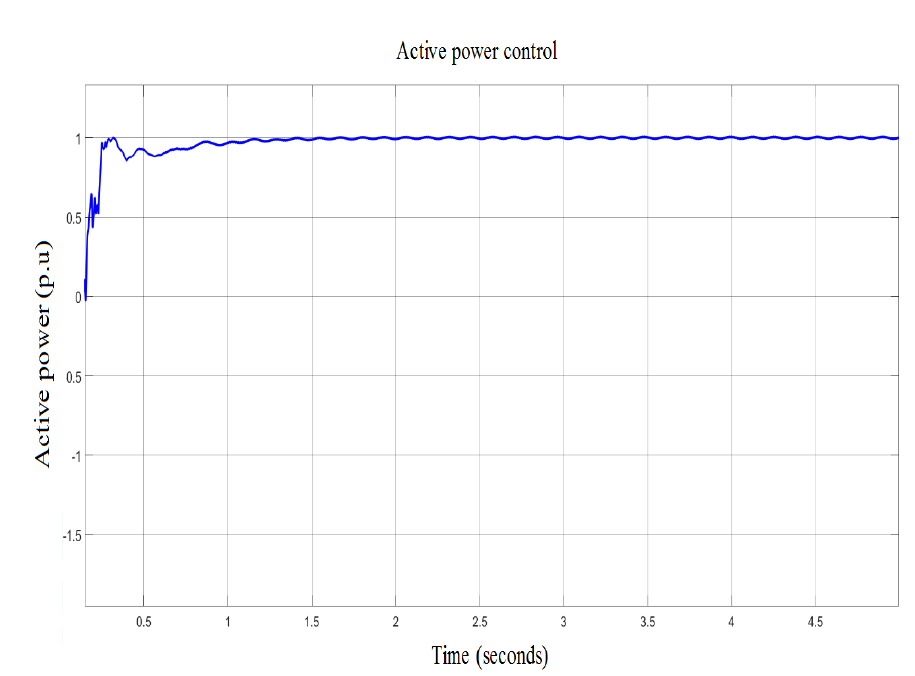
Figure 16. Active power control of inverter.